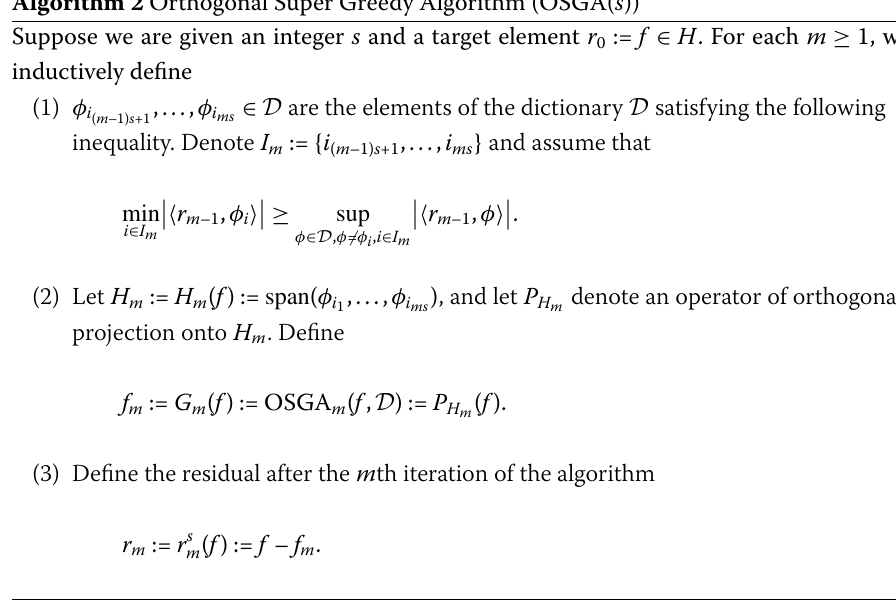
Algorithm 2 Orthogonal Super Greedy Algorithm (OSGA( s